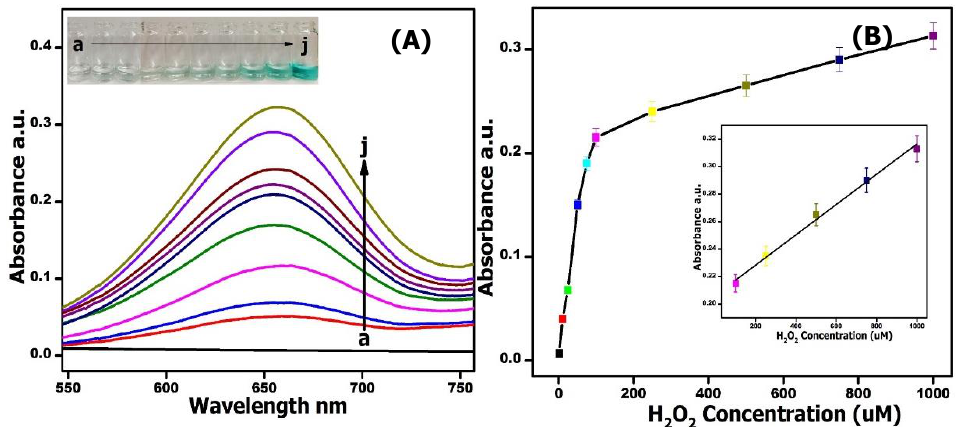
Figure 14. ( A ) records the UV – Vis spectra of the TMB + H 2 O 2 + Zr-GO system with different concen-